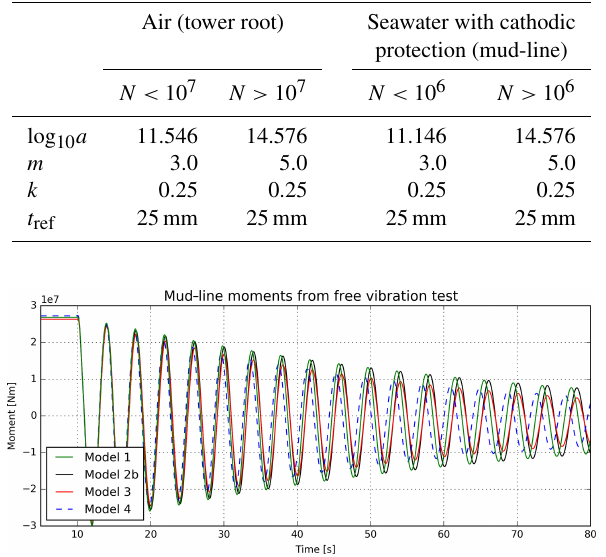
Figure 16. Free vibration test with a tower top displacement of